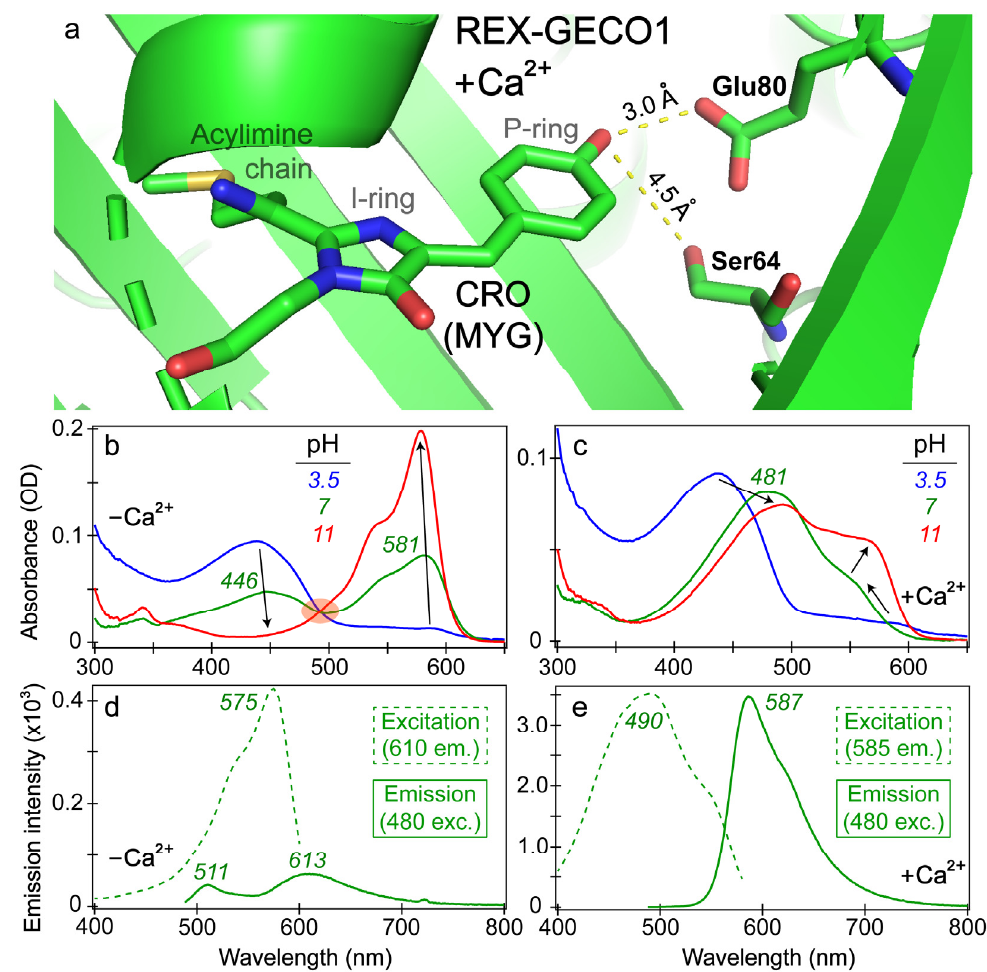
Figure 1. Visualization of the REX-GECO1 chromophore pocket and steady-state electronic spectra. ( a ) Chromophore (CRO) and key residues inside the Ca 2+ -bound REX-GECO1 biosensor, modeled using the progenitor R-GECO1 crystal structure in the Ca 2+ -bound state (PDB ID: 4I2Y) [20]. Inter- actions between the chromophore phenolic end and key surrounding residues are highlighted by dashed yellow lines, with the distances labeled in angstrom units. Distinct chromophore P- and I-ring moieties and the acylimine chain at the I-ring end are labeled. Steady-state absorption spectra of the ( b ) Ca 2+ -free and ( c ) Ca 2+ -bound REX-GECO1 biosensor are shown at pH values of 3.5 (blue), 7 (green), and 11 (red). Black arrows denote major peak changes with the pH increase. The shaded orange ellipse in panel b highlights the isosbestic point as the pH varies. The excitation (dashed) and emission (solid) spectra of the ( d ) Ca 2+ -free and ( e ) Ca 2+ -bound biosensors are shown in pH 7 buffer with the excitation profiles recorded at the emission wavelengths of 610 and 585 nm, respec- tively. The emission spectra were both collected upon 480 nm excitation of the biosensor.